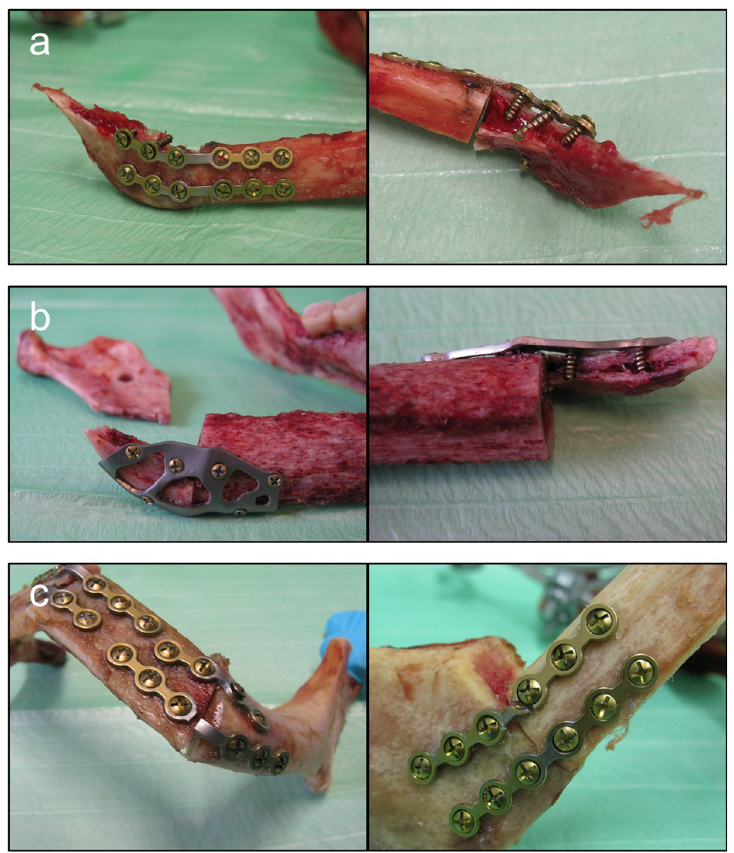
Fig 7. Failure cases of the biomechanical testing. Bone fracture occurred at the right mandibular angle with the fracture line running across the upper fixation screws for (a) miniplates (two views) and (b) TOPOS-implants (two views); (c)Failure of the implant only occurred for reconstructions with miniplates at both fixation sites of the mandibular segment to the fibular segment(left: left mandibular segment to central fibular segment; right: right mandibular segment to right fibular segment).